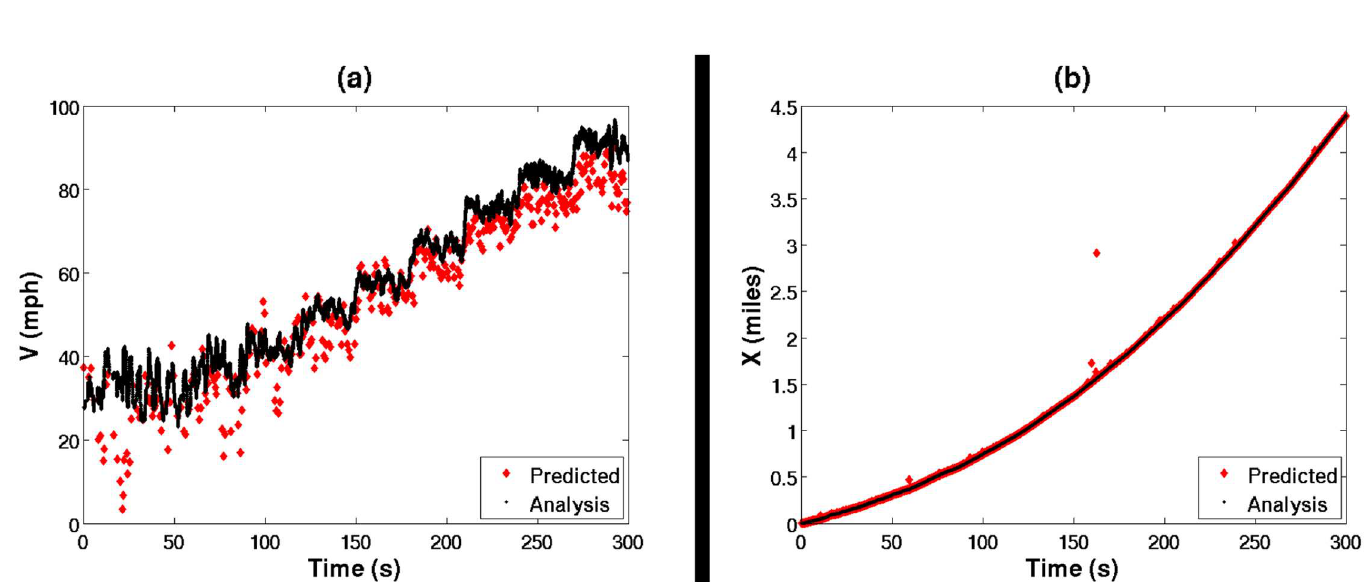
Fig 2. Predicted with the sensorlessalgorithm, and simulated motor analysis results of both (a) the EVL velocity, as well as (b) the integrated distance traveled.